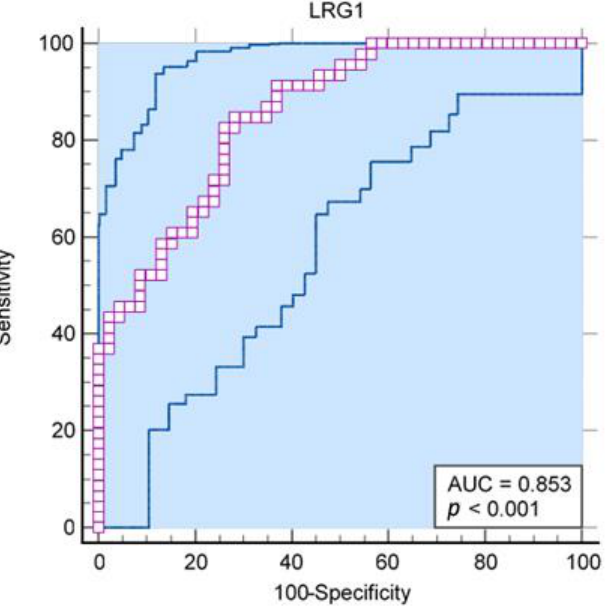
Figure 1. Receiver operating characteristic curve for LRG1 from human saliva as a predictor of acute appendicitis (AUC = 0.85; 95% CI 0.76–0.92; p < 0.001).